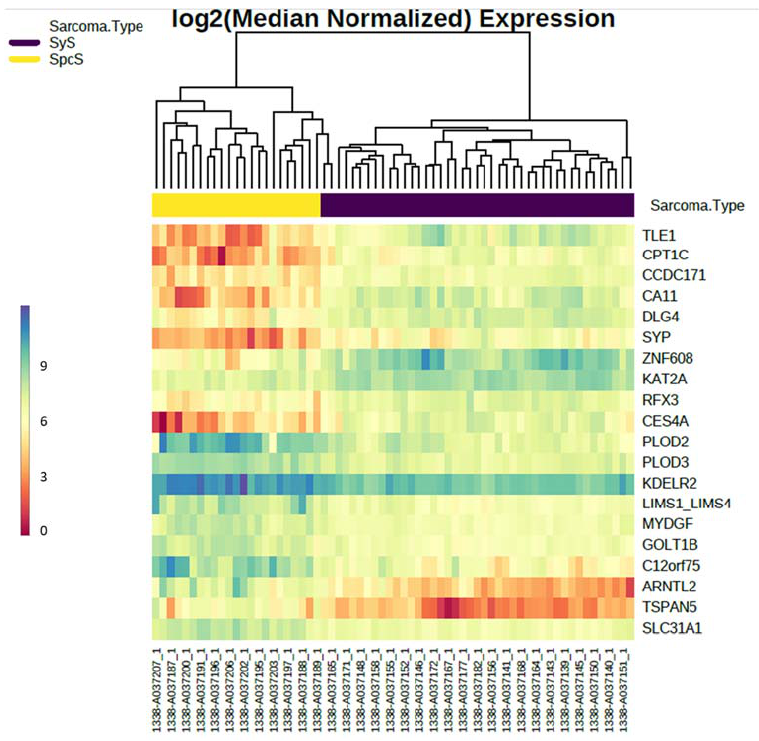
Figure 6. Heatmap of the top 20 differentially expressed genes. Blue bars specify Sys samples, yellow bars specify SpcS samples. The value of expression is colored from blue to red. High expression is indicated by blue (value = 10) and low expression by the red (value = 0) boxes. Yellow bars indicate a value of 6).